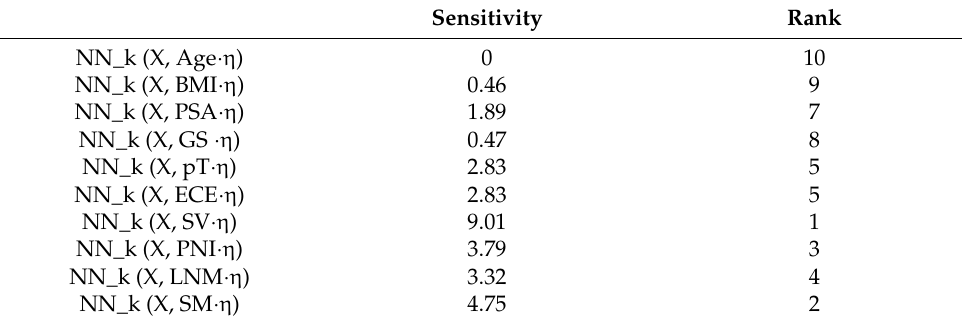
Table 3. Results of partial correlation analysis. PSA, prostate-specific antigen; BMI, body mass